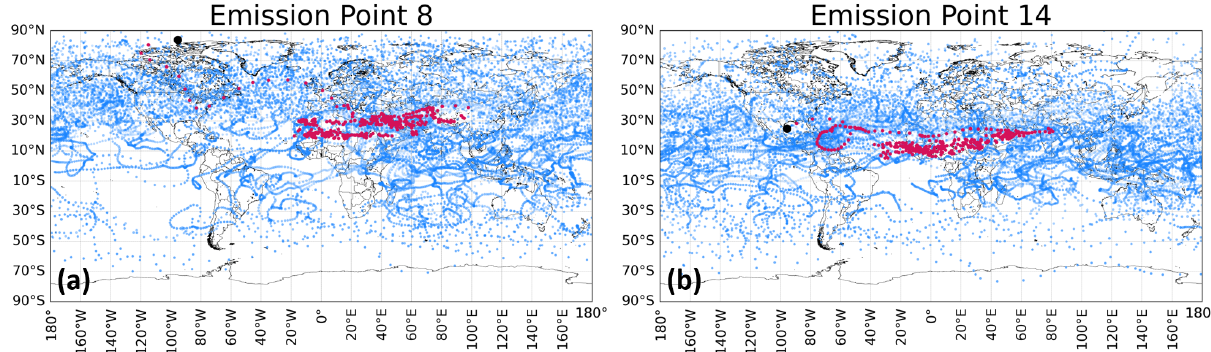
Figure 9. Horizontal trajectories for air parcels released in N. America. The black dots denote the emission starting points. Both are located on the Northern Hemisphere in winter (January–March). The red dots represent the median trajectory, while the blue dots represent the 50 Lagrangian trajectories from (a) emission point 8 within the meridional tilt and (b) emission point 14 within the westerly and outside of the meridional tilt. The age of the air parcel trajectories is accounted for with variable blue transparency so that ending points appear